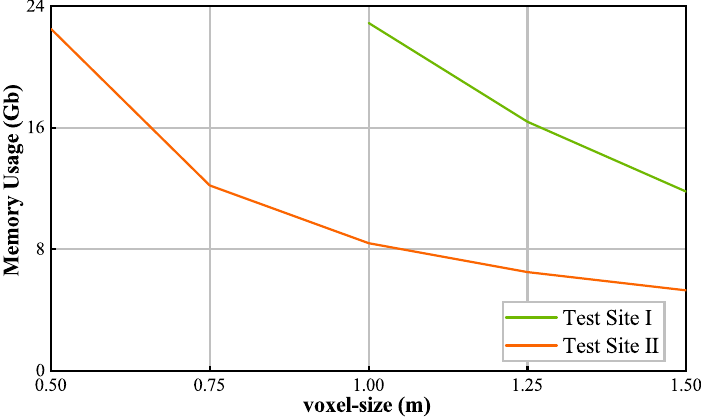
Figure 7. Maximum memory usage of MinkowUnet34C-based segmentation method on the test set, with a batch size of 1 and a coverage of 384 m for one forward pass.